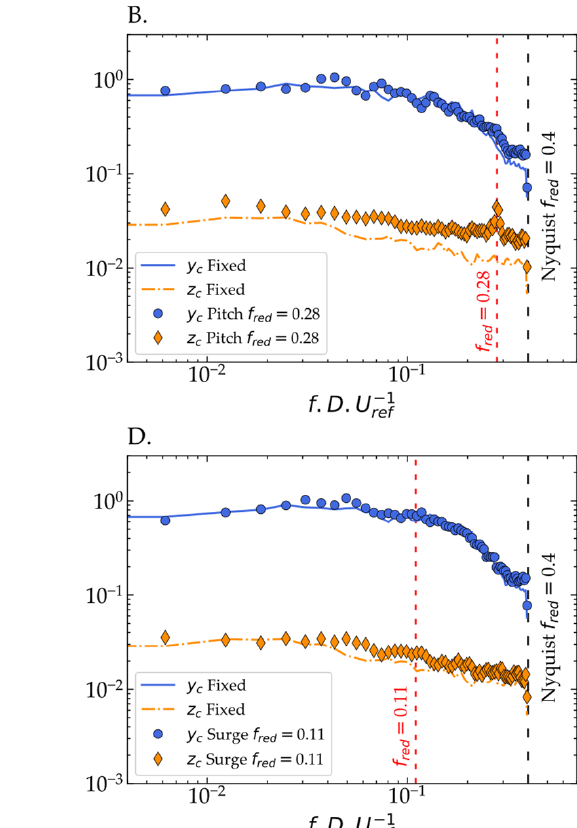
Figure 10. Comparison of the power spectral density (PSD) of lateral and vertical wake centre for the model with two cases of fixed and imposed 3D motion.